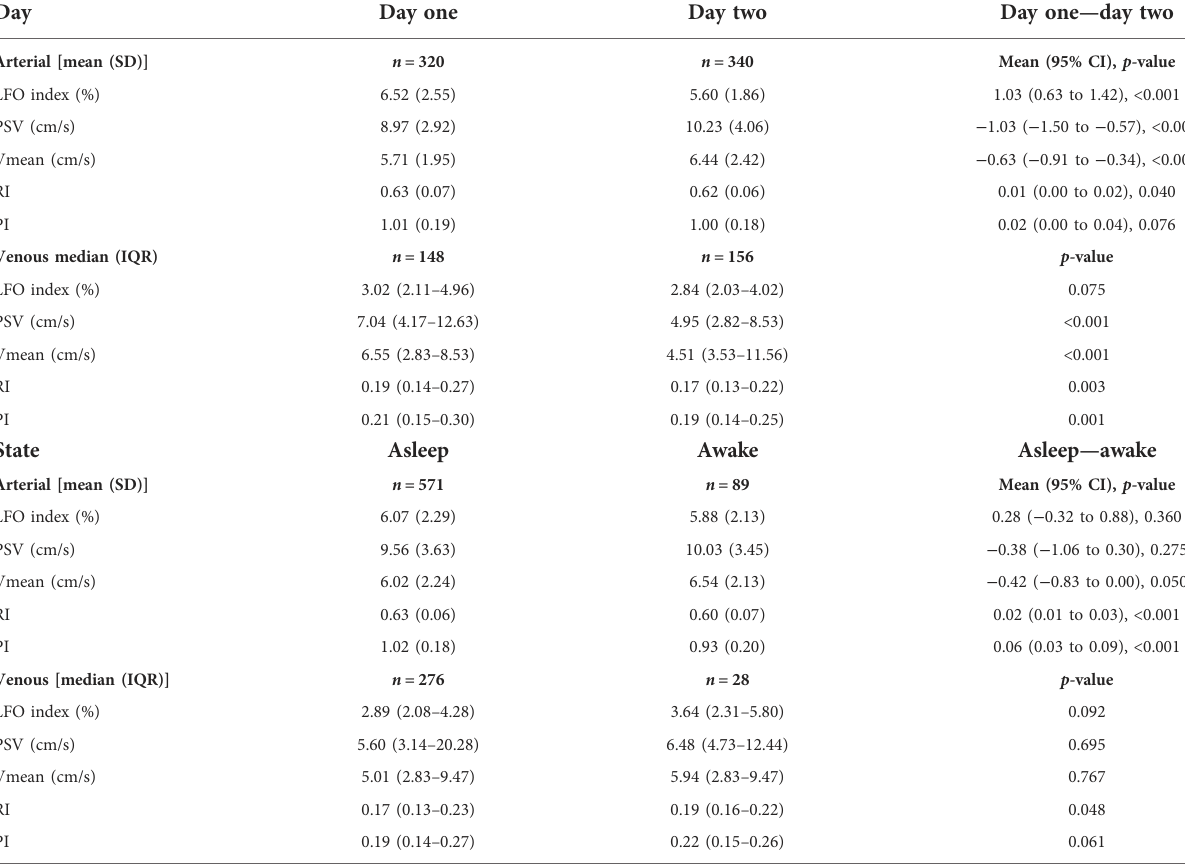
TABLE 2 Cerebral hemodynamics by postnatal age and behavioural state.